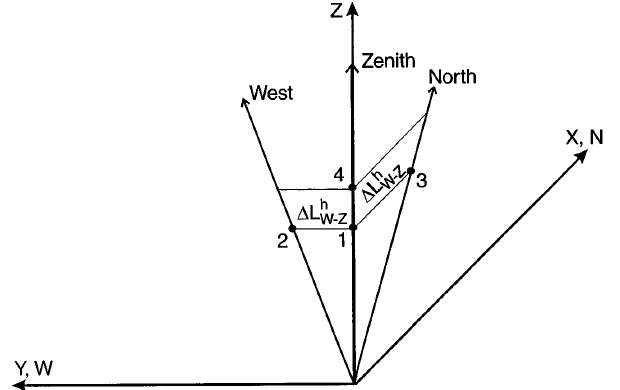
Fig. 1. Schematic representation of the 3-beam radar experiment used to determine TID/AGW propagation characteristics. Radar beams at 40 (cid:176) elevation angle to the north and the west were interleaved with vertical observations with the Millstone Hill